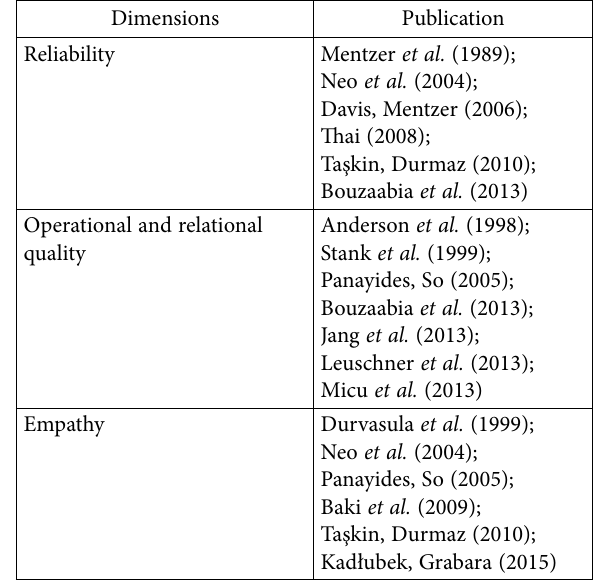
Table 3. Review of dimensions for the measuring of